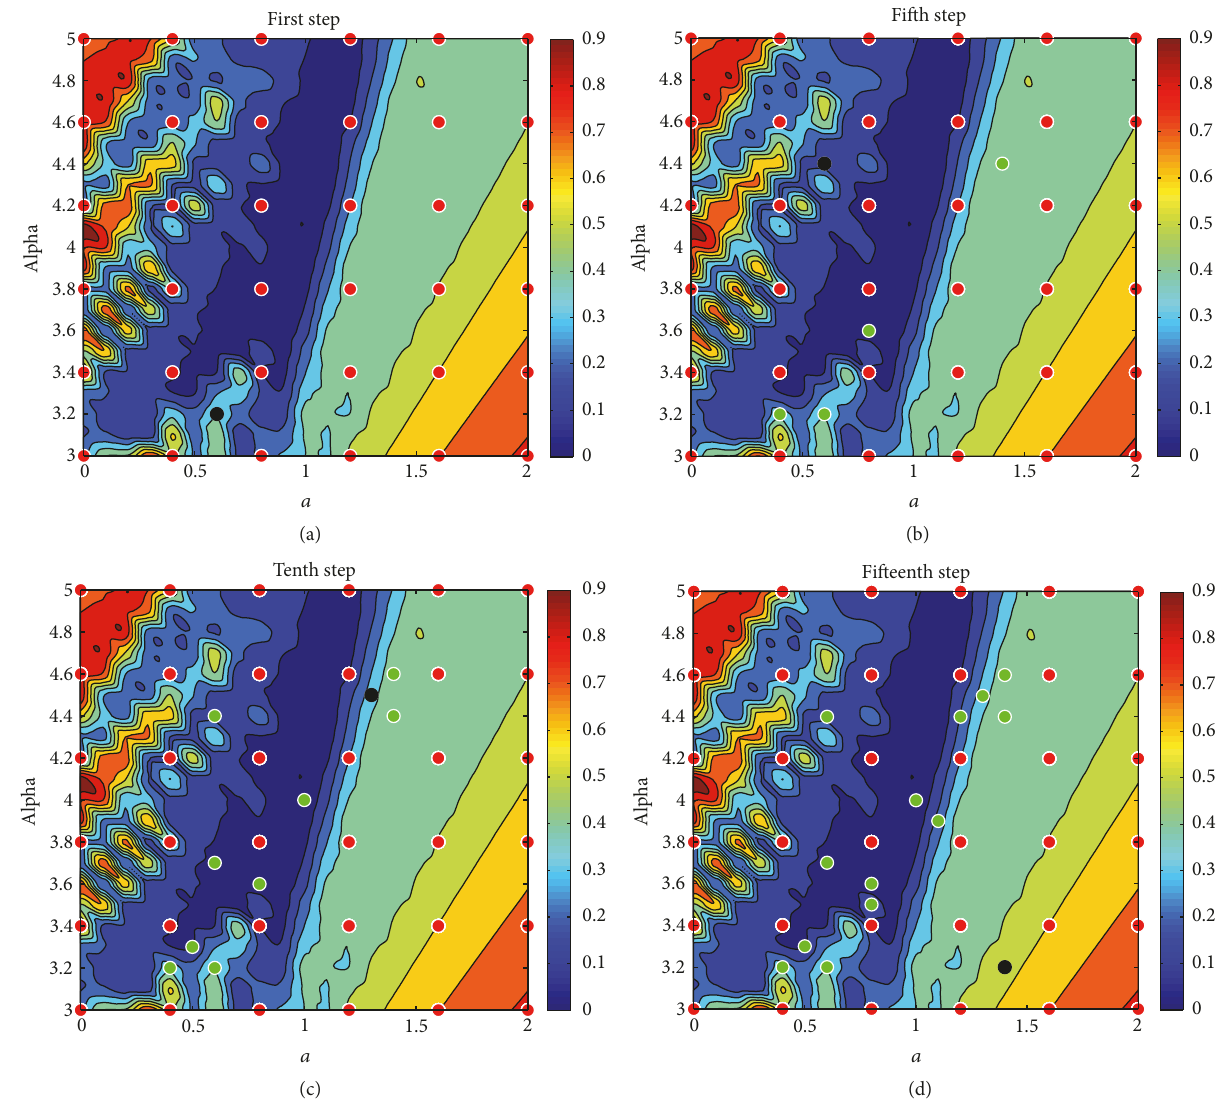
Figure 2: Process of finding the best parameters using TMED algorithm. (a), (b), (c), and (d) represent the first, 5th, 10th, and 15th iteration, respectively. It can be seen that the individuals (points) converge to the optimum area. Red, green, and black points show the first, newly generated, and queen data in every